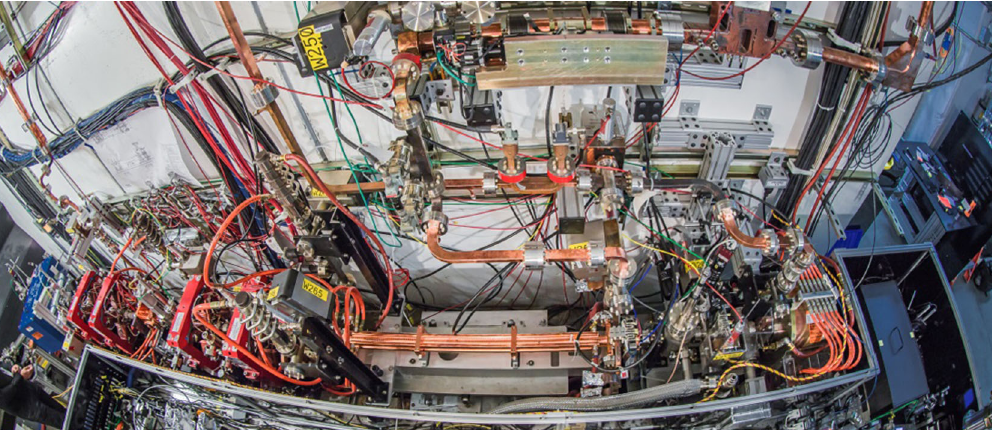
FIG. 2. X-Band test area beamline. The 1.05 m long copper accelerator structure is seen in the middle of the photo, and one of three phase shifters is visible on the wall. The apparent curvature of the beamline is an artefact of the wide-view camera lens.